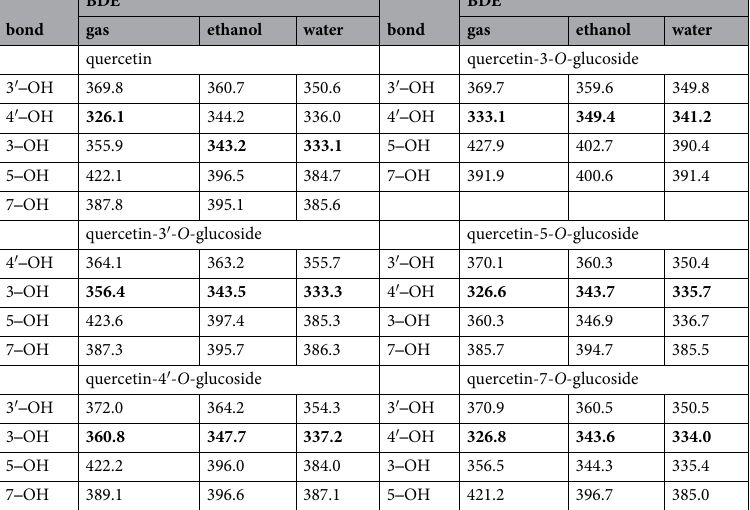
In addition to the magnitude of BDEs, the stability of radical is another important factor that influences anti- oxidative activity of flavonoids. The more stable radical may indicate stronger antioxidative capacities of the com- pound. Spin density is a reliable parameter in rationalizing the stability of radical species 20, 28, 29 . The spin density